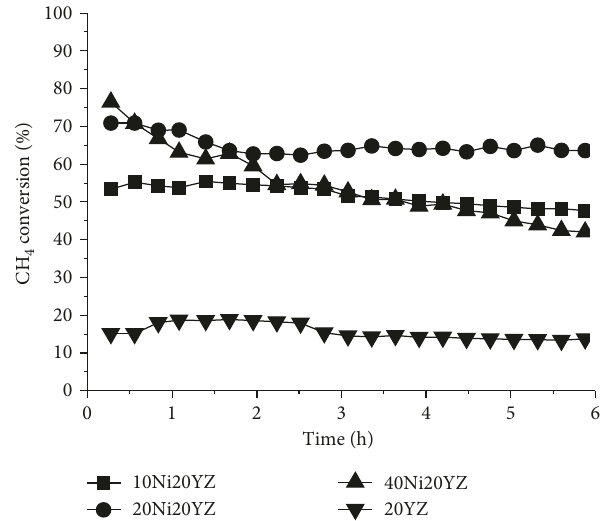
Figure 7: Conversion of CH 4 results obtained during the catalytic tests in the oxidative reform of methane at 750 ° C (molar ratio of reactants 1.5CH 4 :CO 2 :0.25O 2 ; molar total flow: 107mL · min − 1